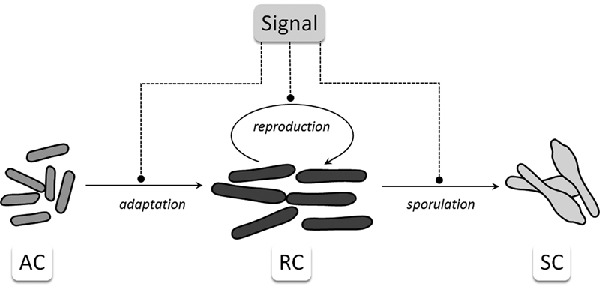
Clostridium botulinum is one of the significant organisms associated with foodborne hazards, and improved mathematical models which account for complex growth patterns make important contributions to improved food safety.